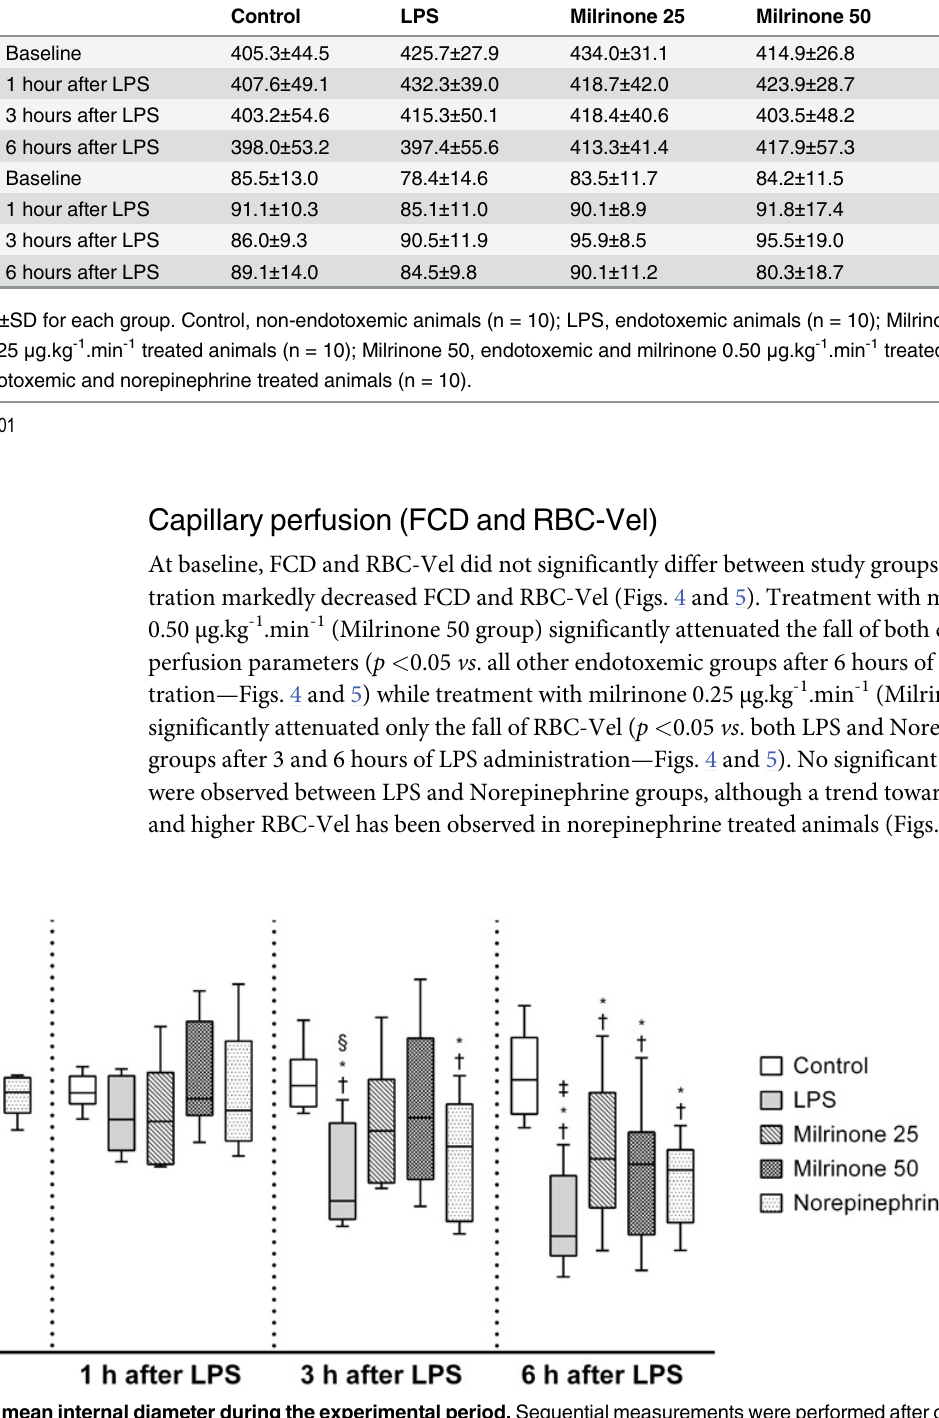
Fig 3. Evolution of arteriolar mean internal diameter during the experimental period. Sequential measurements were performed after one, three, and six hours of LPS injection. Control, non-endotoxemic animals (n = 10); LPS, endotoxemic animals (n = 10); Milrinone 25, endotoxemic and milrinone 0.25 μ g.kg -1 .min -1 treated animals (n = 10); Milrinone 50, endotoxemic and milrinone 0.50 μ g.kg -1 .min -1 treated animals (n = 10); Norepinephrine, endotoxemic and norepinephrine treated animals (n = 10). † p < 0.05 vs . group baseline; * p < 0.05 vs . Control group at the same time point; ‡ p < 0.05 vs